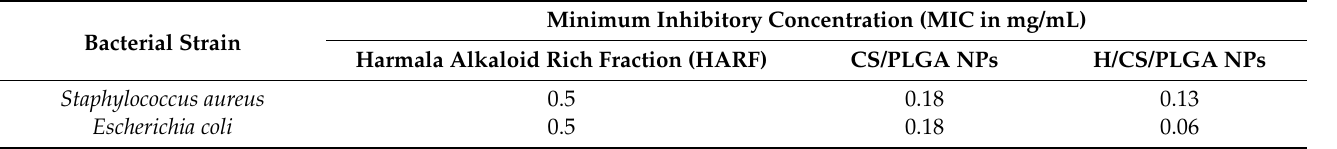
Table 3. Antibacterial activity of optimal H/CS/PLGA NPs and free HARF against Staphylococcus aureus and Escherichia coli . Minimum Inhibitory Concentration (MIC in mg/mL) Bacterial Strain Harmala Alkaloid Rich Fraction (HARF) CS/PLGA NPs